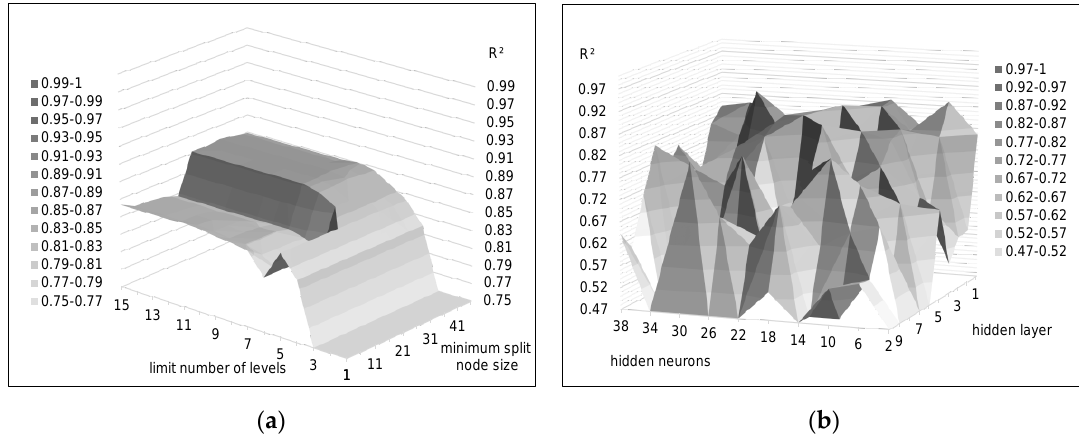
Figure 14. Surface plot of hyperparameter assessment: ( a ) R 2 for simple regression tree algorithm; ( b ) R 2 for multilayer perception algorithm.